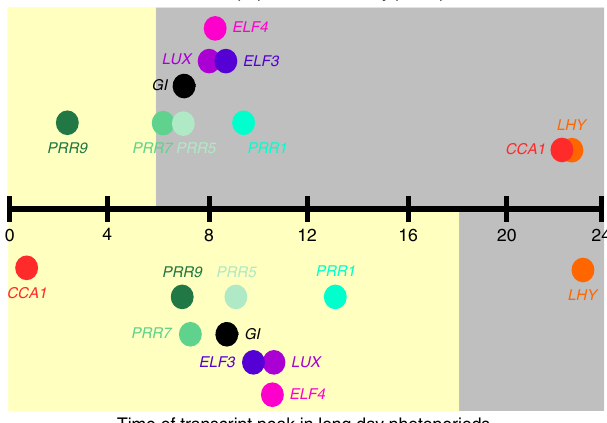
Fig. 2 The loosely coupled nature of the oscillator is demonstrated by the plasticity of peak time of expression of the components of the circadian oscillator. Peak of oscillator transcript abundance is plotted against time since dawn (h). Upper plot: a photoperiod of 6 h light (yellow box) and 18 h dark (grey box); lower plot:18 h light 6 h dark. The time of the peaks shifts between the photoperiods relative to the external photoperiod and relative to each other. Distance from the time line on the y axis is for plotting clarity and conveys no meaning. The data were obtained from Table S2